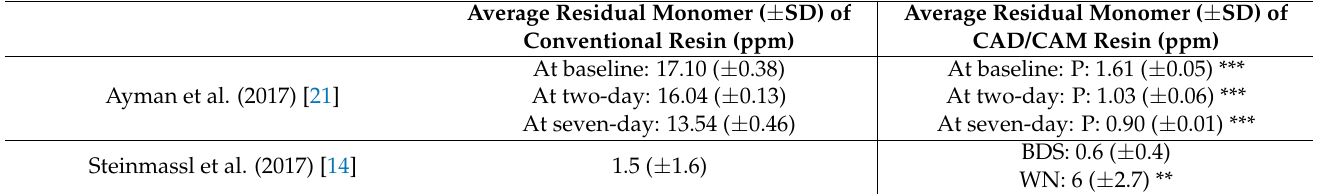
Table 6. Residual monomer content test